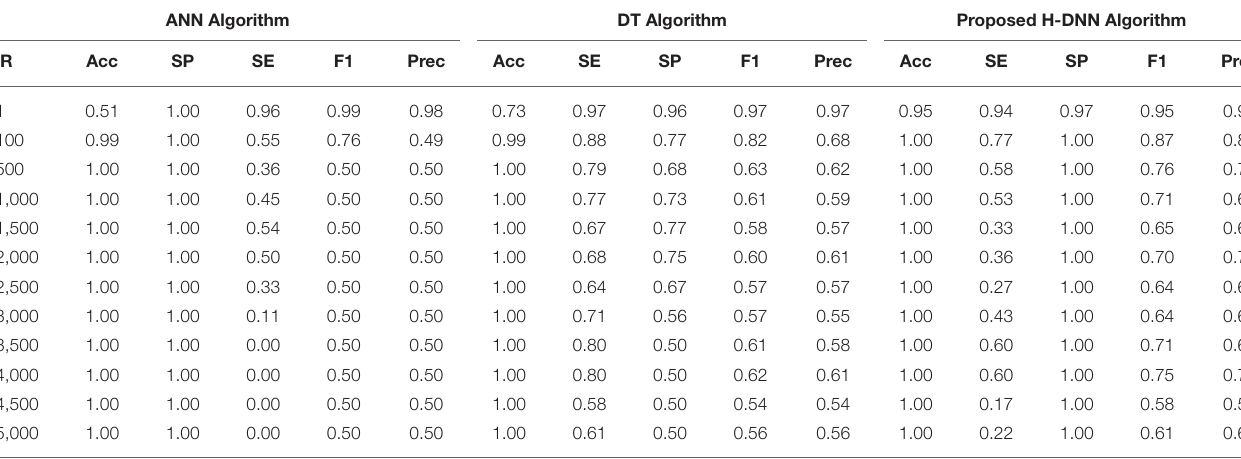
TABLE 5 | Experimental results using plant dataset.